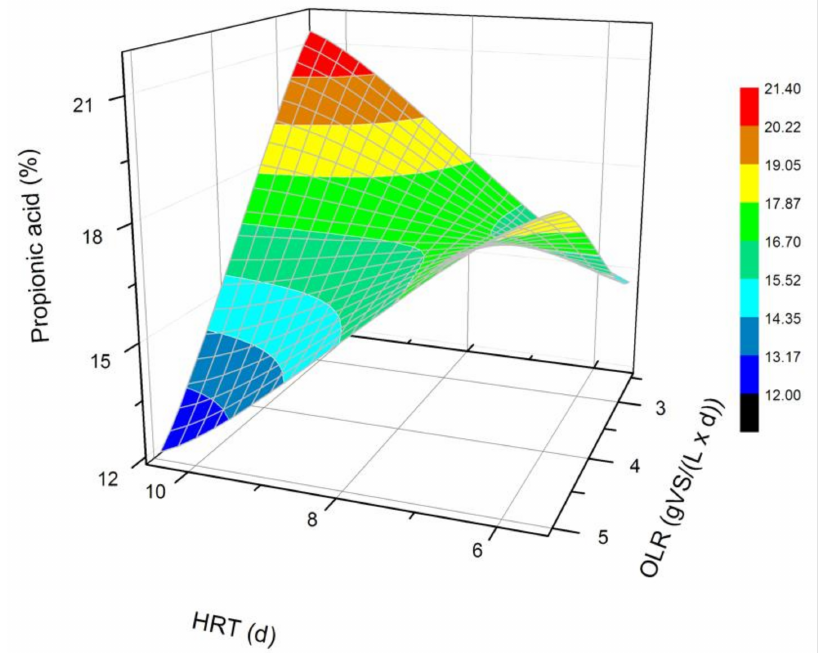
Figure 4. Changes in the content of propionic acid produced in a steady state during the DF process at the OLRs of 2.5 gVS/(L × d) and 5.0 gVS/(L × d) and the HRTs of 5 d and 10 d.